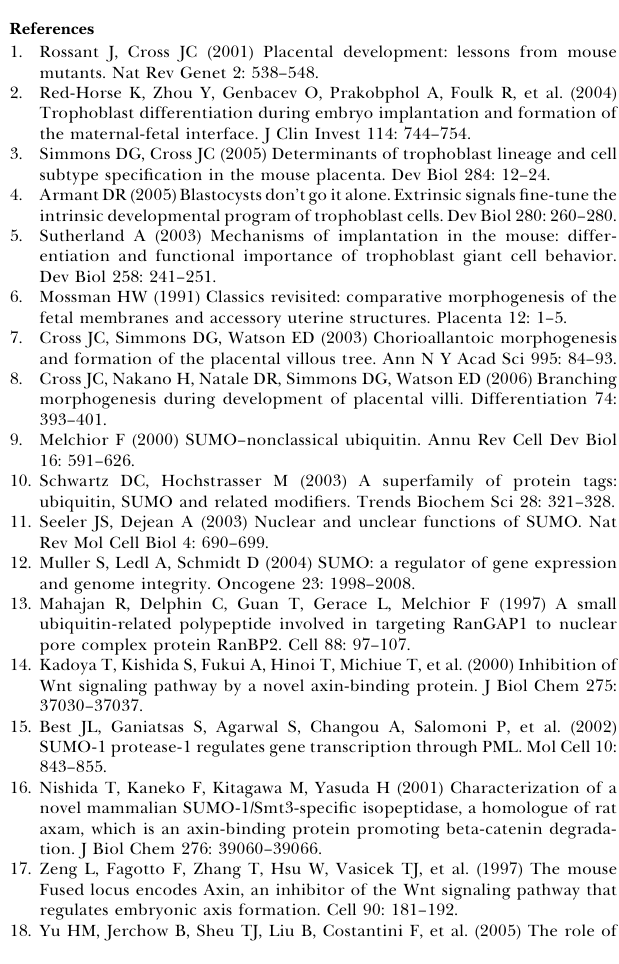
Figure S1. Creation of Mice Carrying a SENP2-Null Allele